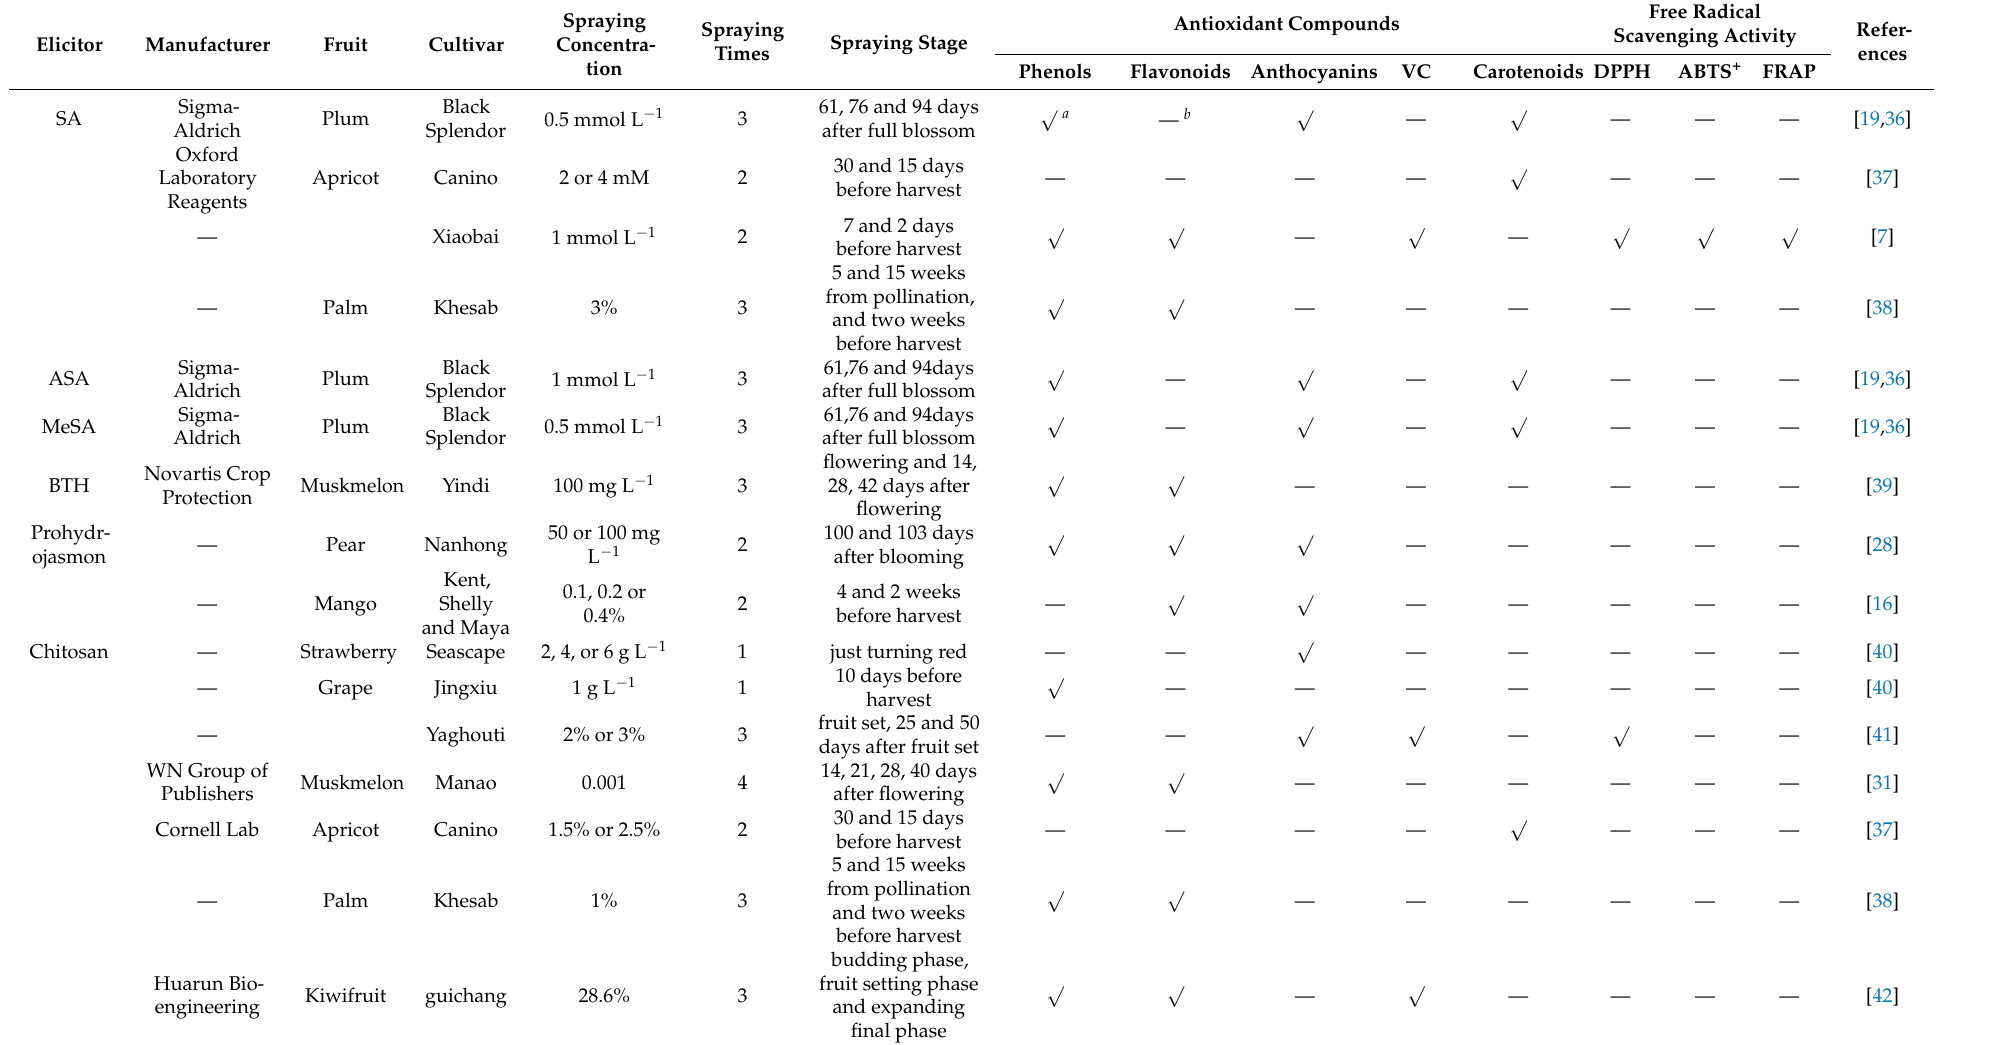
Table 1. Preharvest elicitors spray improves antioxidant compounds and freeradicalscavengingactivity in